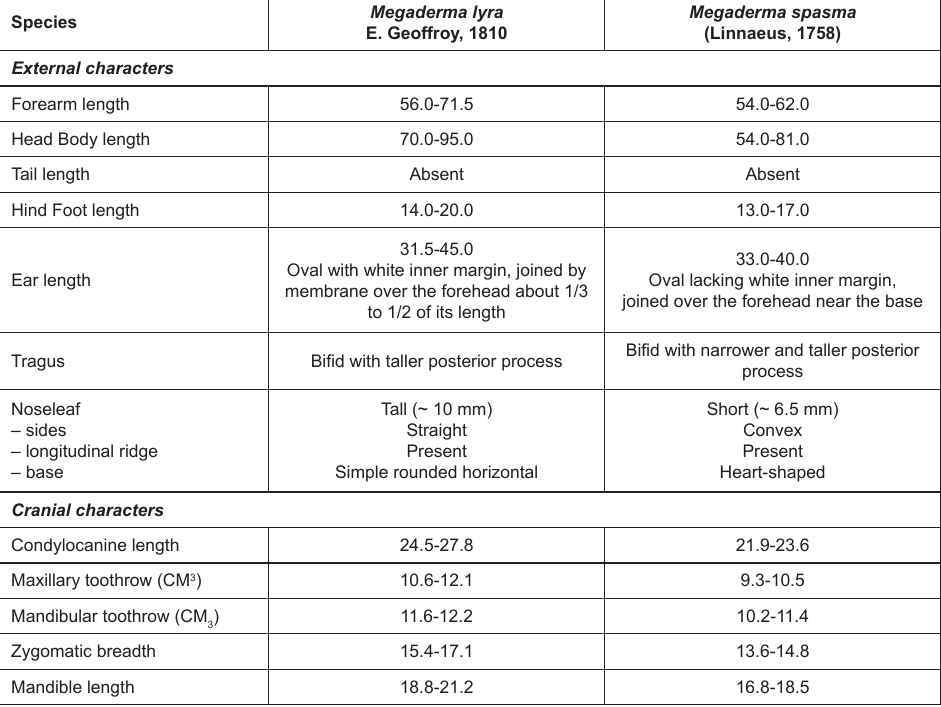
Table 4.3. Diagnostic morphological characters of the two species of the genus Megaderma E. geoffroy, 1810 present in South